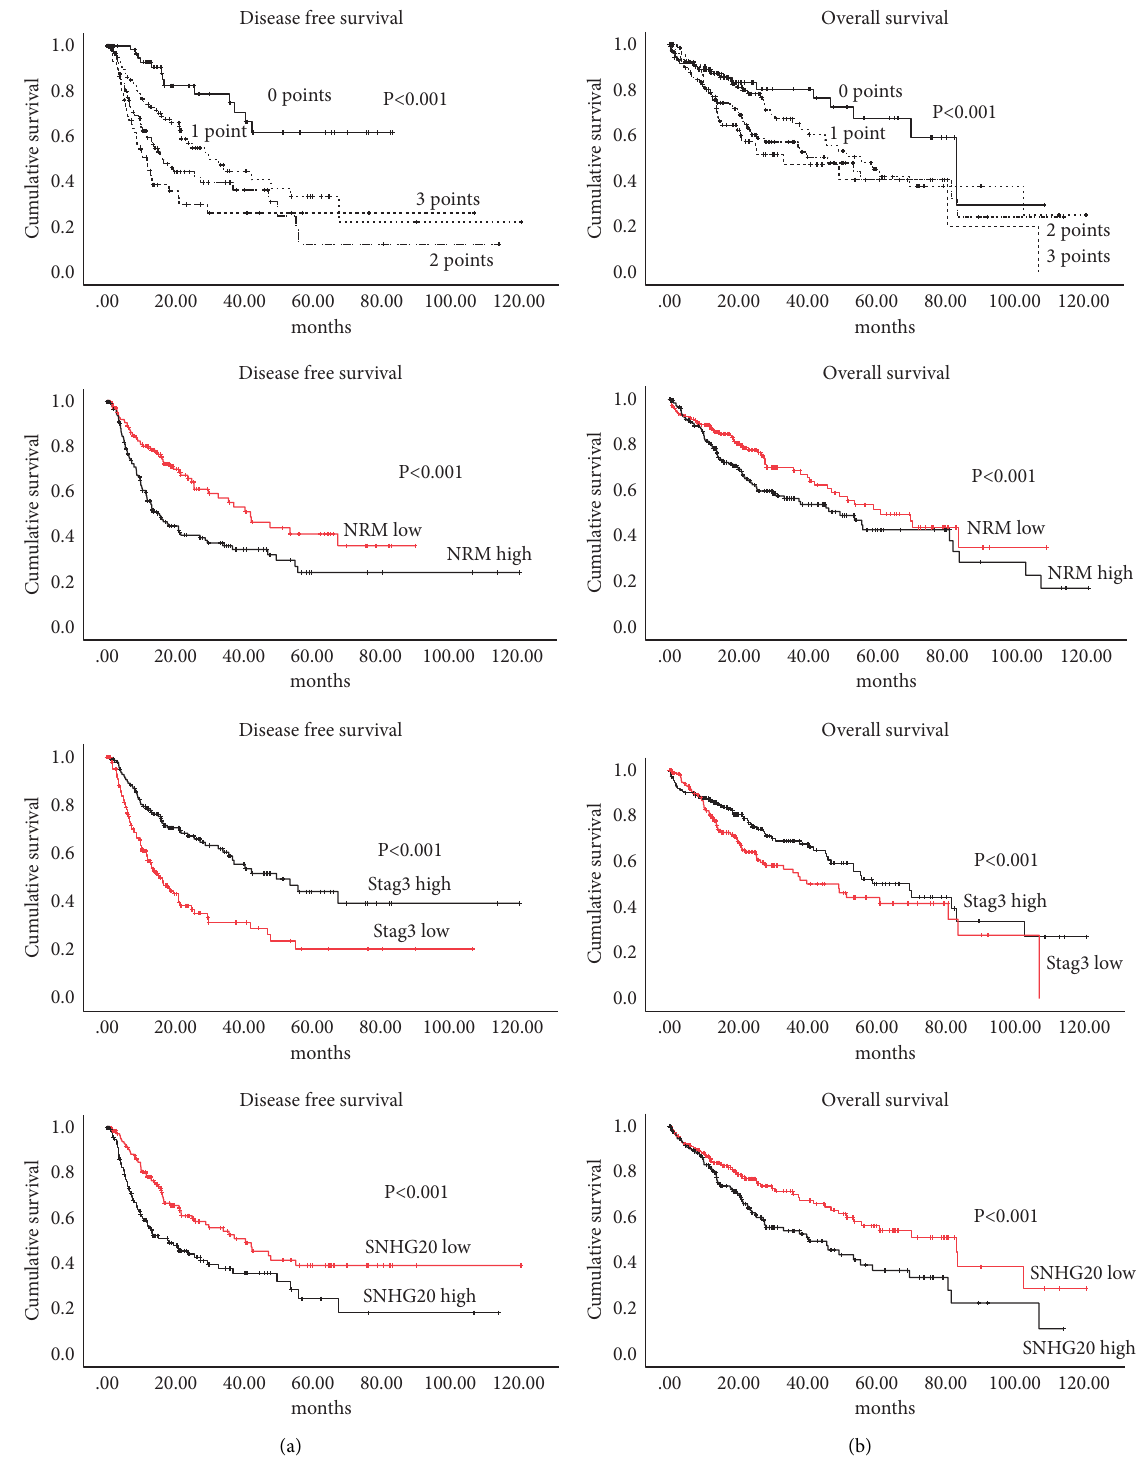
Figure 3: (a) Disease-free survival and (b) overall survival: Kaplan–Meier curve of calculated scores and Kaplan–Meier survival curves for each gene based on cutoff value derived from CTA analysis (gene expression < cutoff or ≥ cutoff, respectively) and Kaplan–Meier curve combination of calculated